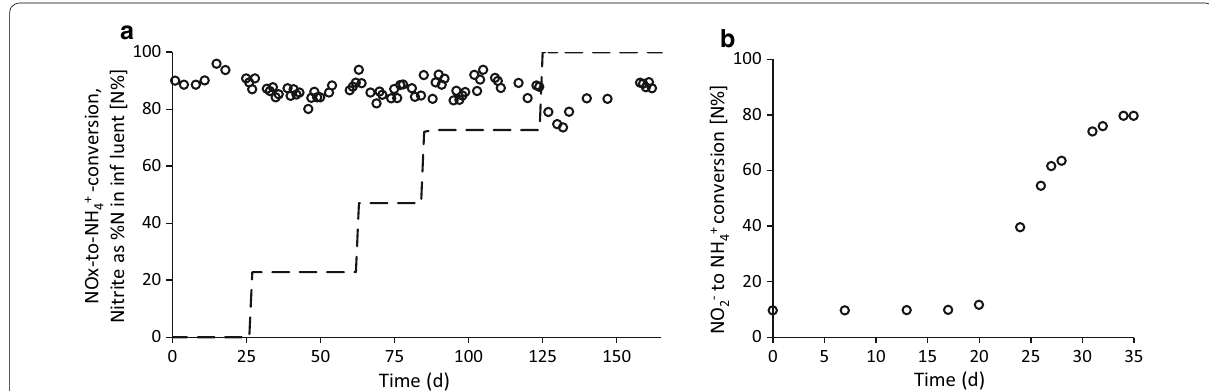
Fig. 1 Ammonium production in the acetate fed chemostat systems, as a percentage of the NO x conversion in time. This includes both dissimila- tory and assimilatory production of ammonium. a Ammonium production ( open circles ) for the varying percentages of NO 2 − in the influent nitro- gen ( dashed line ). The other influent nitrogen was nitrate. b Ammonium formation in the enrichment inoculated with activated sludge with nitrite as electron